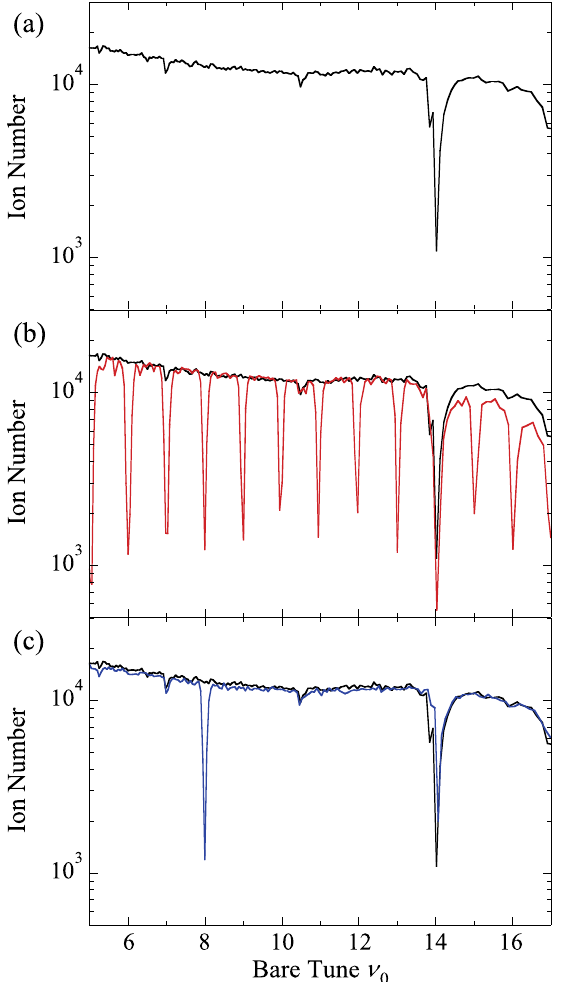
FIG. 4. Resonance stop bands identified by the S-POD system. Starting with roughly 10 4 ions in the LPT, we measured the final ion number after 10 ms at various fixed tunes. There are 140 data points of independent measurements in the tune range 5 ≤ ν ≤ 17 . (a) Stop-band distribution with no dipole perturba- 0 tion, (b) stop-band distribution with a piecewise constant dipole perturbation whose pulse height and width are 1 V and 1 μ s, respectively, and (c) stop-band distribution with a sinusoidal dipole perturbation as shown in Fig. 3(b). For reference, the data of the case (a) is replotted with a black solid line in the middle and lower